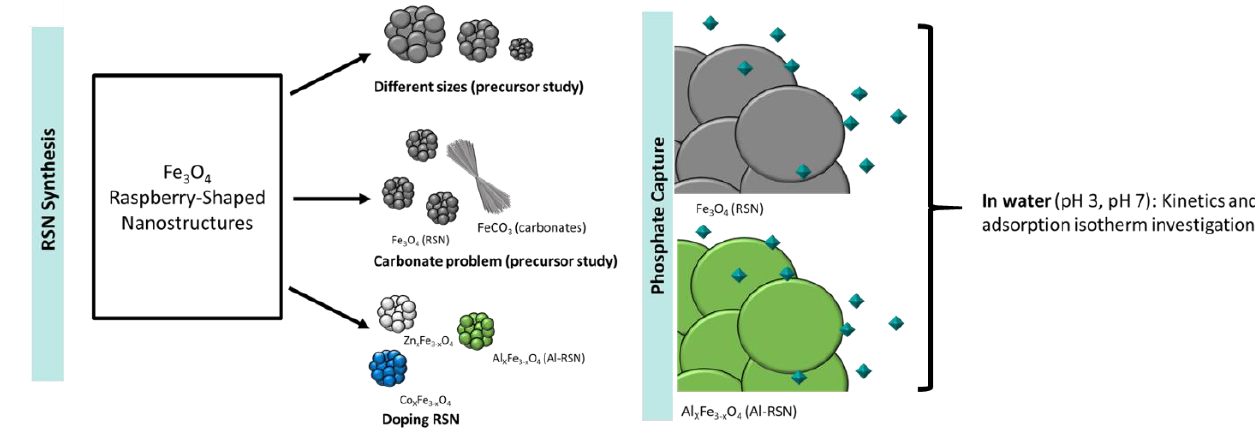
Figure 1. General concept schematizing the different performed investigations on the synthesis of the raspberry-shaped nanostructures and on the evaluation of the RSN and the Al-RSN materials for phosphate removal.